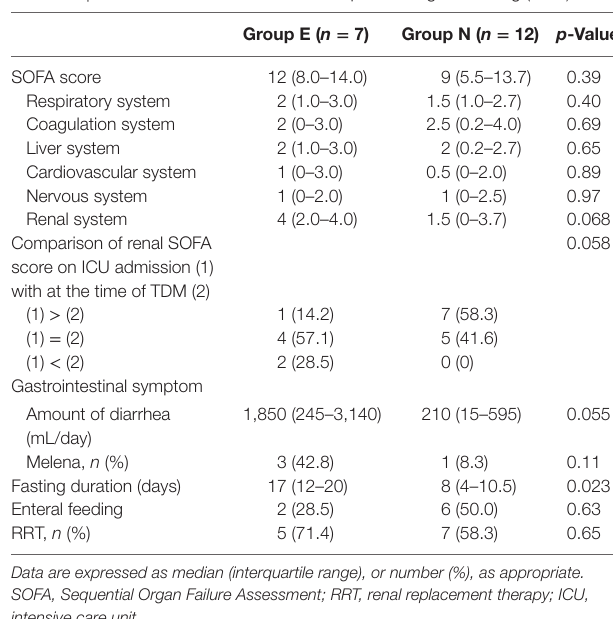
Table 1 | Patients characteristics.